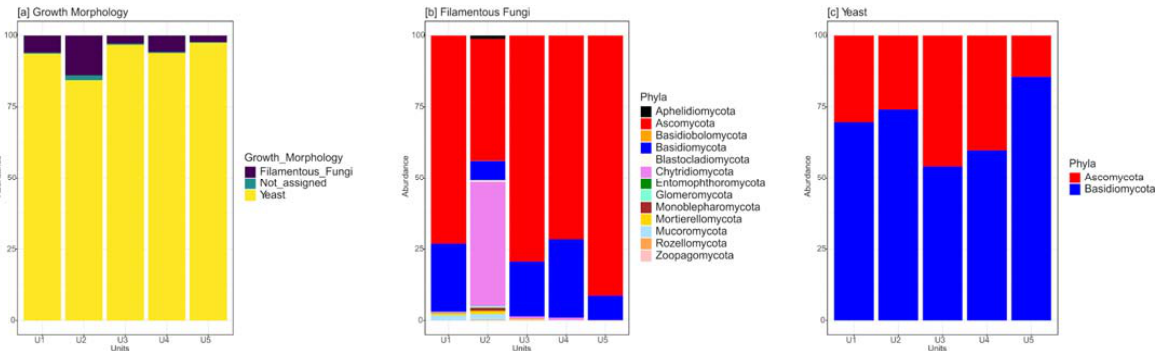
Figure 3. Fungal diversity differently found in the five units of the permafrost core of Adelie Cove rock glacier (U1, U2, U3, U4, and U5). ( a ) Relative abundance of ASVs assigned to yeasts and fi lamentous fungi and their distribution among these two life forms; ( b ) relative abundance of ASVs assigned only to fi lamentous fungi phyla; and ( c ) relative abundance of ASVs assigned only to yeast phyla.